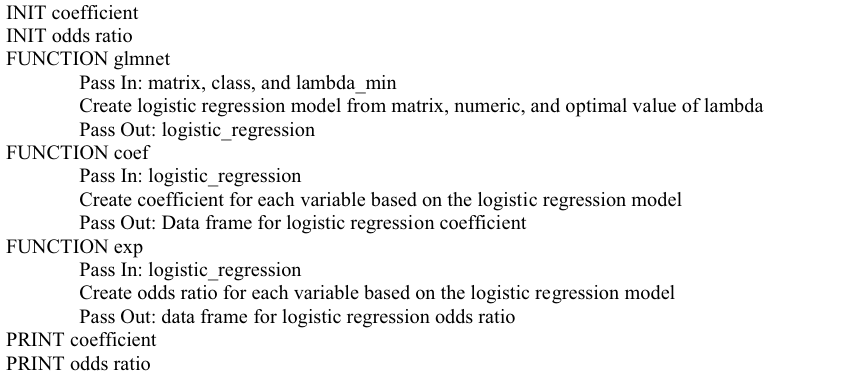
Table 9 Pseudocode to execute Logistic Regression to find Odds Ratio and Logistic Regression Coefficient for each variable INIT coefficient INIT odds